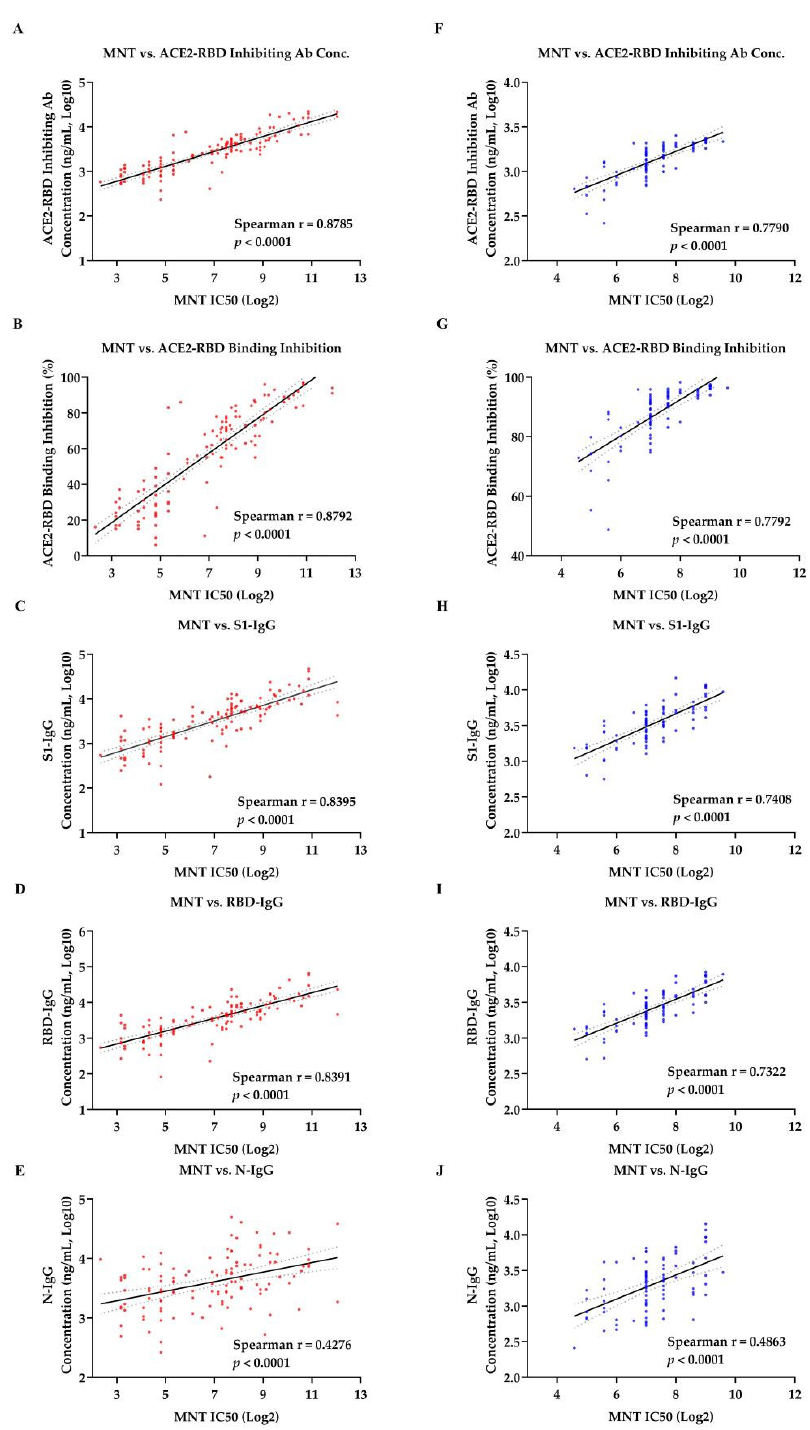
Figure 5. Correlation among microneutralization test (MNT), ACE2-RBD inhibition assay or SARS- CoV-2 specific IgG tests in samples. Correlation of 119 convalescent samples ( A – E ) and 86 vaccinated samples ( F – J ) test results were computed by nonparametric spearman correlation. ( A , F ) Correlation of MNT and ACE2-RBD inhibiting Antibody concentration. ( B , G ) Correlation of MNT and ACE2- RBD binding inhibition. ( C , H ) Correlation of MNT and S1-IgG. ( D , I ) Correlation of MNT and RBD-IgG. ( E , J ) Correlation of MNT and N-IgG. Spearman r > 0.7 and p value < 0.05 indicate a strong correlation, Spearman r < 0.7 and p value < 0.05 indicate a weak correlation, while p value > 0.05 indicate no correlation. The solid line represent a linear regression, with 95% confidence intervals represented by dotted